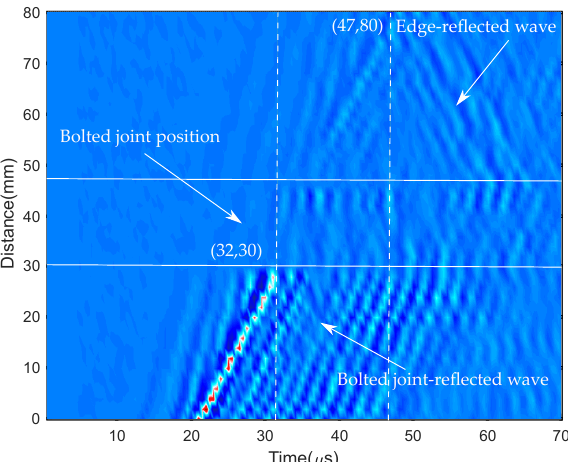
Figure 11. Cross-sectional image of the amplitude of the Lamb wave propagating through the target bolt.